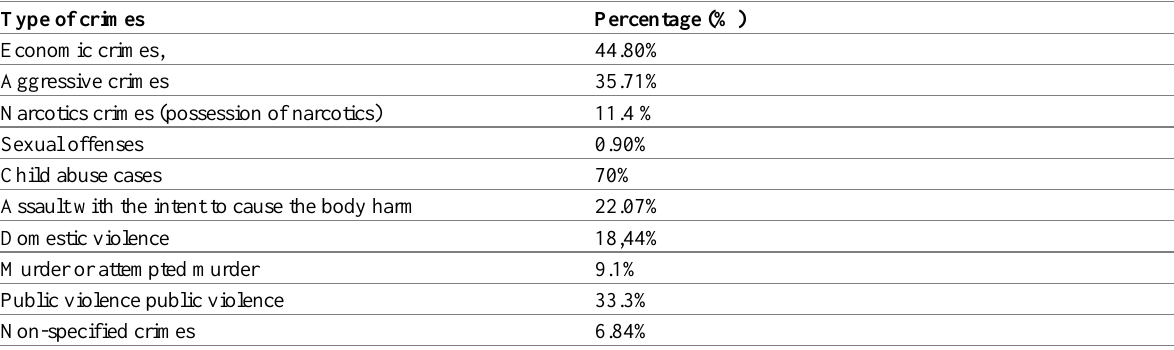
Table 1: Crimes committed by females in South